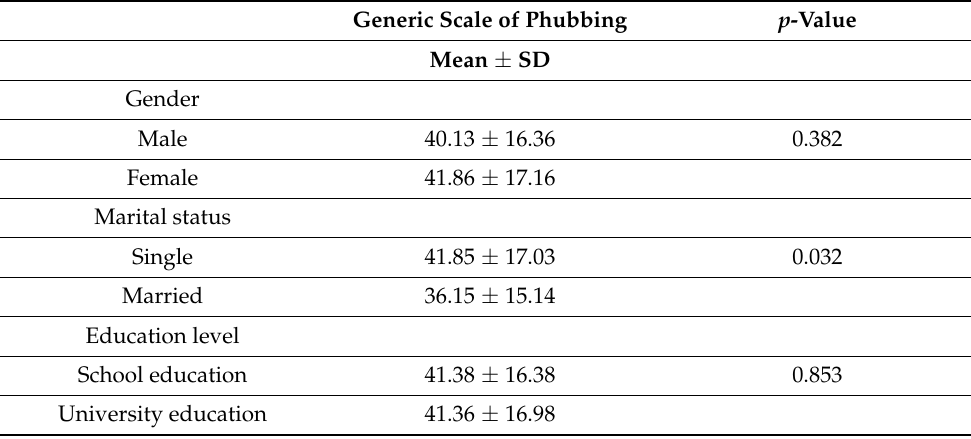
Table 2. Bivariate analysis of categorical variables associated with the phubbing